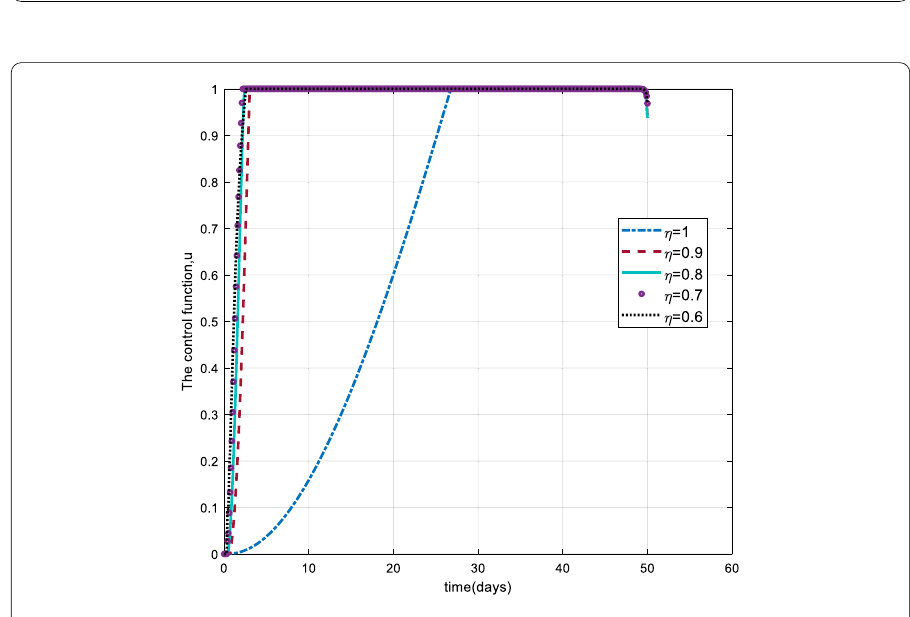
Figure 10 The control profile u ( t ) for different values of the fractional derivative order η